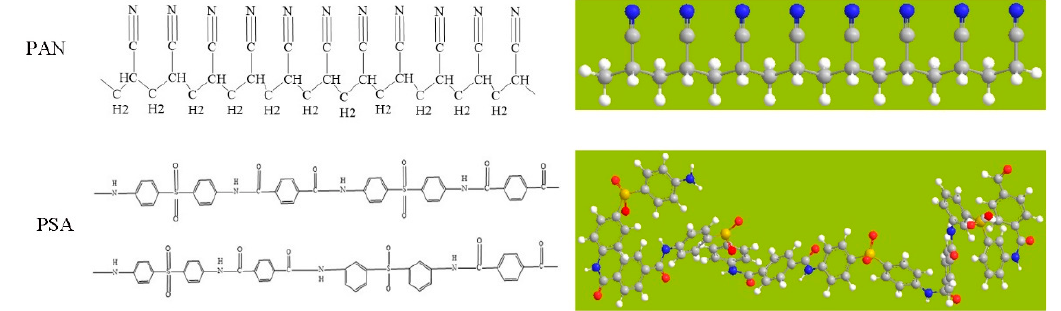
Figure 1. Molecular formulas and 3-D molecular structures of the PAN and PSA.